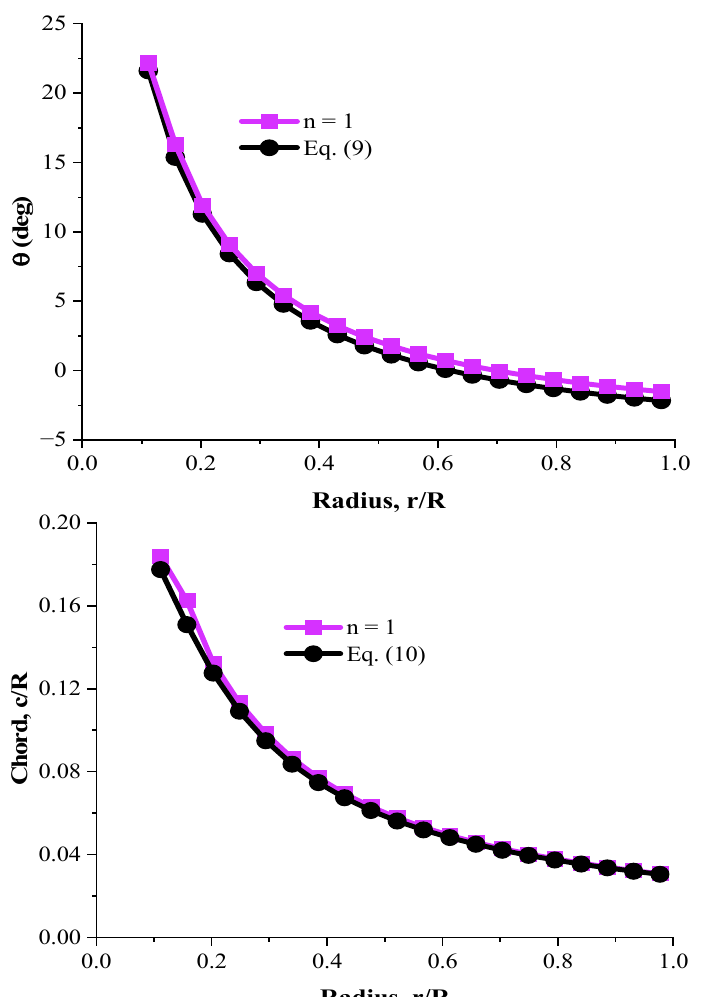
Figure 7. The distributions of θ ( top ) and c ( bottom ) obtained from the optimization algorithm and ideal correlations.